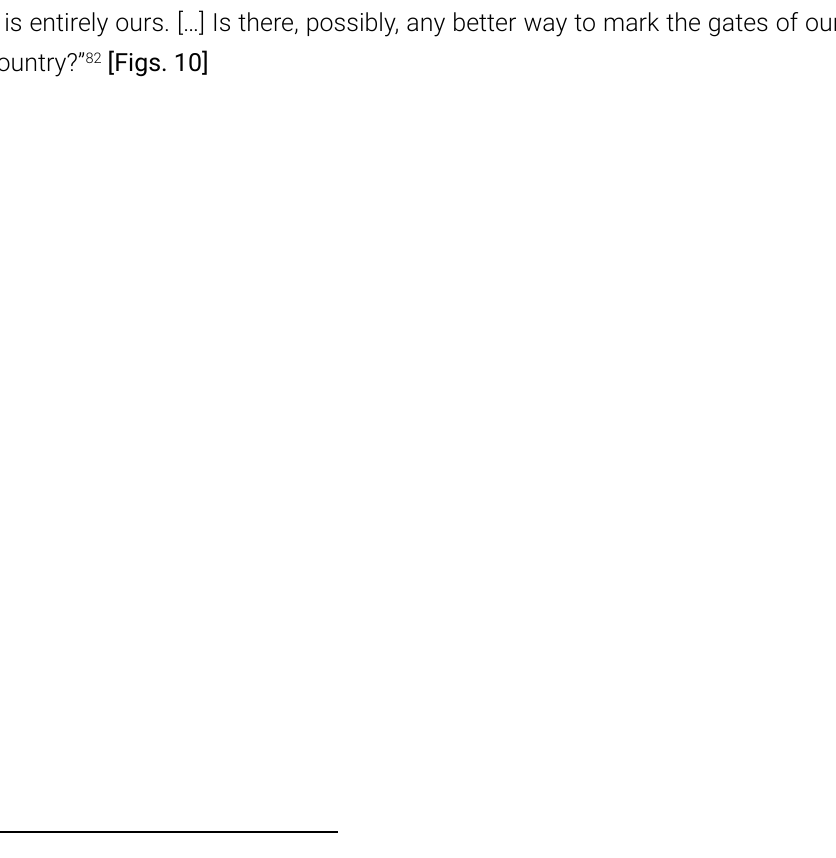
Fig. 10 Bogdan Bogdanović’s sketch for the beleg. (Source: Mali Urbanizam (Sarajevo: Narodna prosvjeta, 1958),